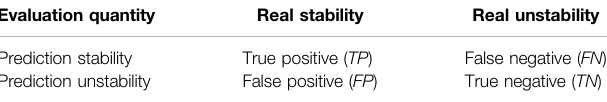
TABLE 1 | Confusion matrix for